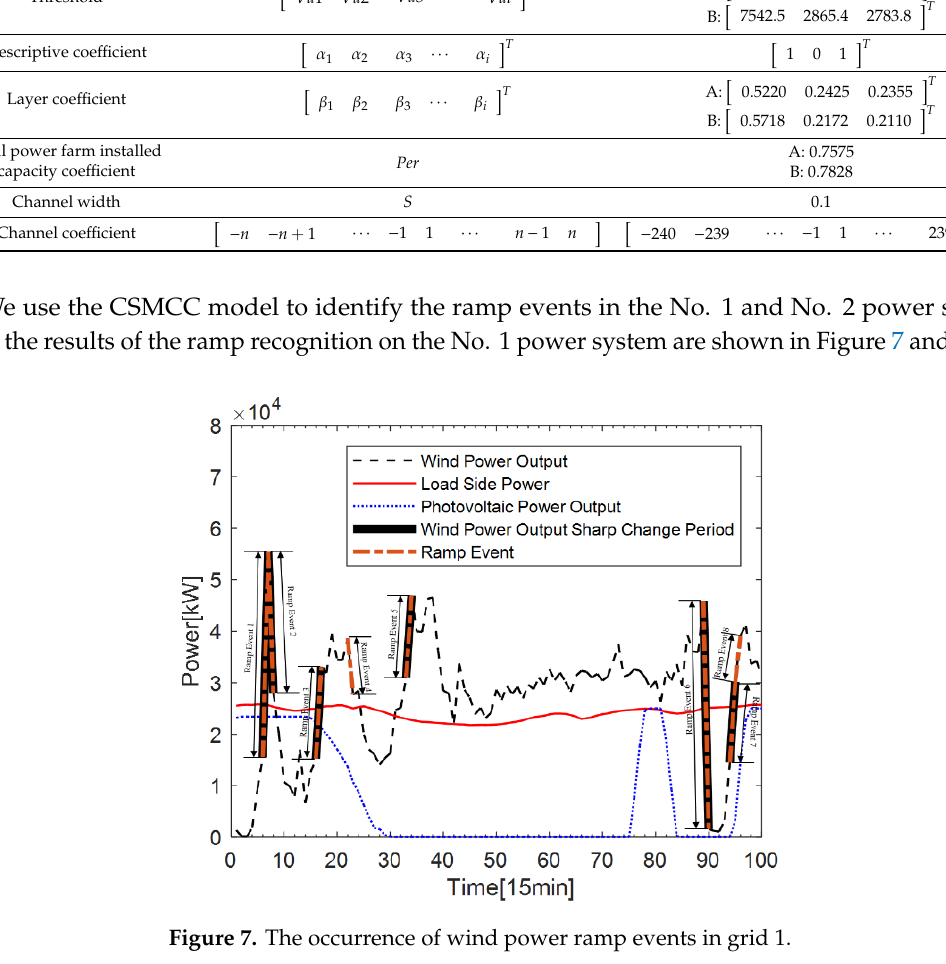
Table 3. Parameters of channel self-selection multi-layer coe ffi cient correction model (CSMCC) in No. 1 and No. 2 power systems.